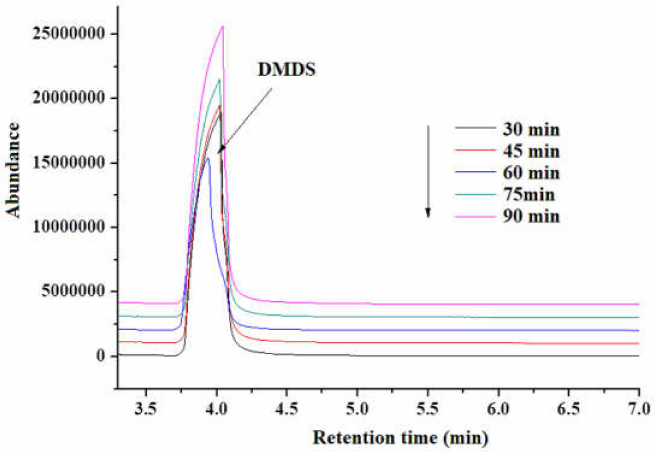
Figure 6. The GC-MS spectra of the DMDS product under different reaction time. Experimental